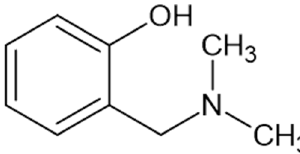
Figure 11. Chemical structure of 2-((dimethylamine)methyl)phenol (2-DMAMP). 2-DMAMP was also used for detection and identification of G-type nerve agent traces in environmental matrices. During their research, Weissberg et al. tested various solvents, obtaining the best results for water. This method was used to analyze envi- ronmental samples exposed to G-type nerve agents, such as asphalt, linoleum, cloth and concrete, which resulted in LOD between 0.8 and 20 pg/cm 2 . The other sample was earth, in which they detected nerve agents on a 4 pg/g level [123]. Shellfish and seafood are popular foods that can be contaminated by ingesting dia- toms. The contamination may result in the presence of domoic acid–a natural neurotoxin found in Pseudo-nitzschia (of diatom genus) (Figure 12). Consumption of the contami- nated food can cause acute intoxication or even death, therefore the upper limit of do- moic acid in shellfish has been established at 20 mg/kg of edible tissue. Beach et al. [124] developed a method of qualitative analysis of domoic acid by derivatization with dansyl chloride, which resulted in a 5-fold increase in molar response in MS, as well as im- proved chromatographic behavior.